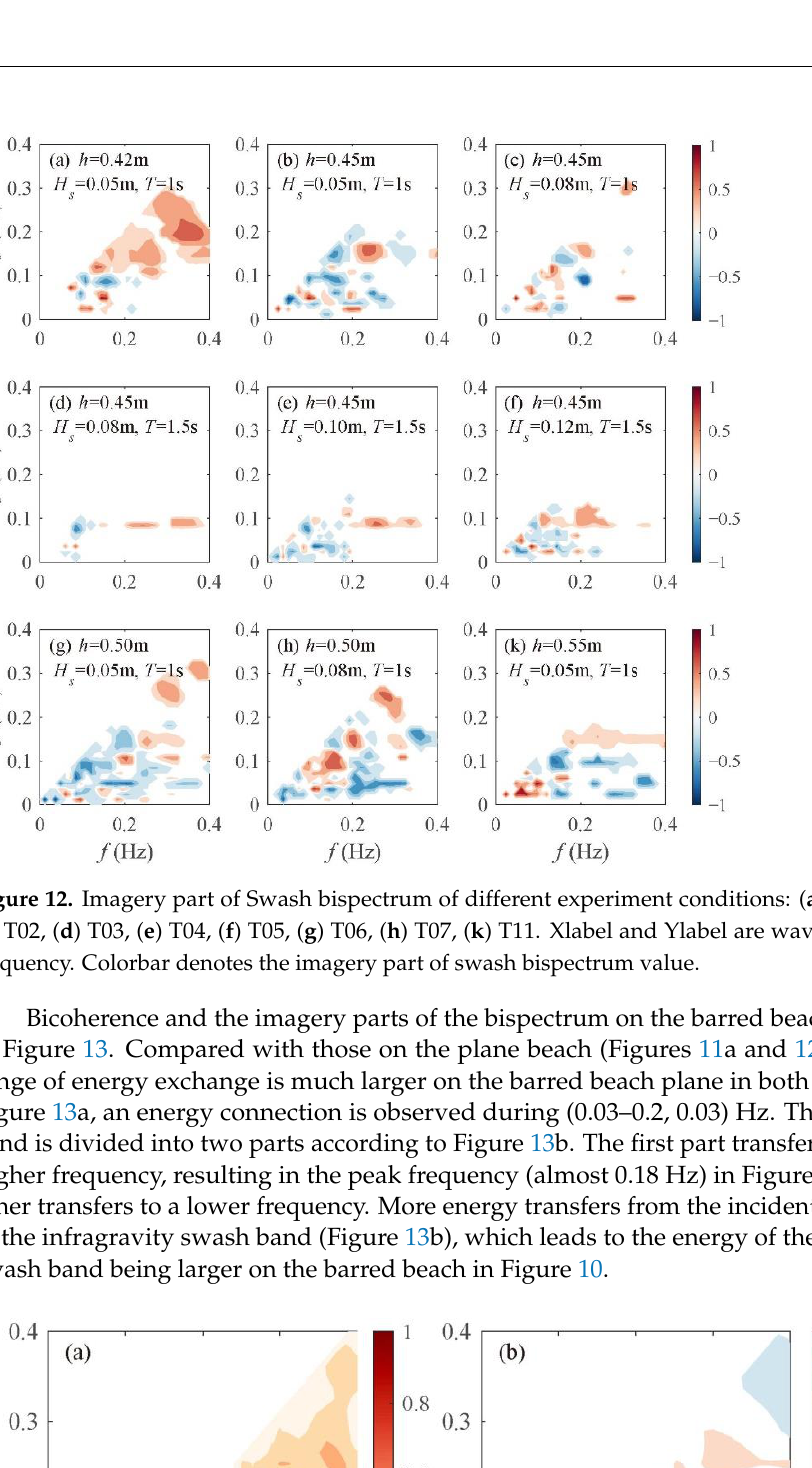
Figure 11. Swash bicoherence of different experiment conditions: ( a ) T00, ( b ) T01, ( c ) T02, ( d ) T03, ( e ) T04, ( f ) T05, ( g ) T06, ( h ) T07, ( k ) T11. Xlabel and Ylabel are wave components frequency. Colorbar denotes the degree of swash bicoherence.